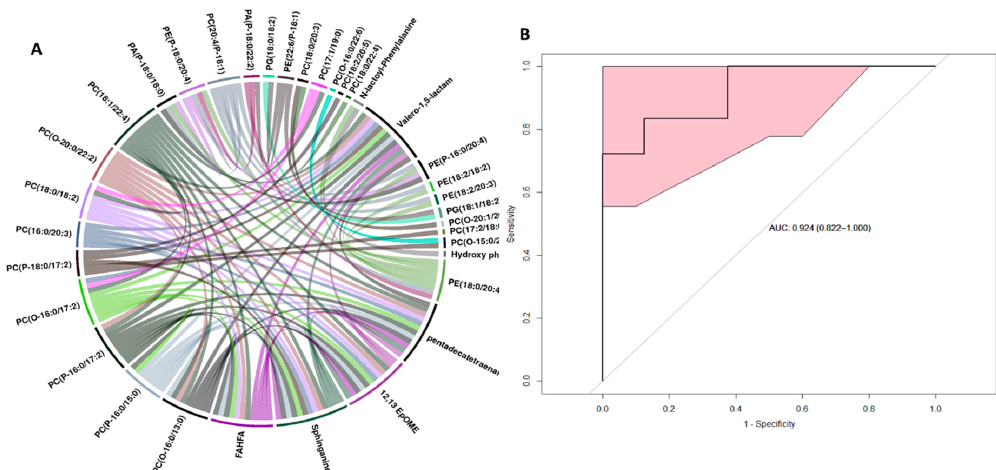
Figure 4. Metabolomic and Lipidomic profiles of kidney in NHPs pre and post-irradiation. Panel A: Three dimensional PLS-DA plot showing separation of healthy NHPs (N = 8) from those who either survived (N = 18) or succumbed to radiation-induced (N = 14) tissue injury within 60 days.Prediction accuracy for 100 permutations yielded a p-value of 0.07. Panels B and C: the relative abundance of significantly dysregulated metabolites and lipids in the threes study groups, respectively.